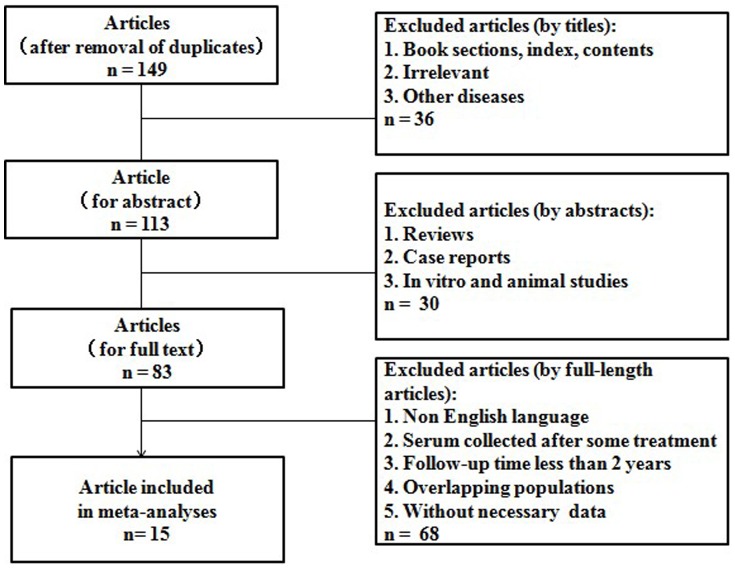
Flow chart showing the inclusion and exclusion process of literatures.